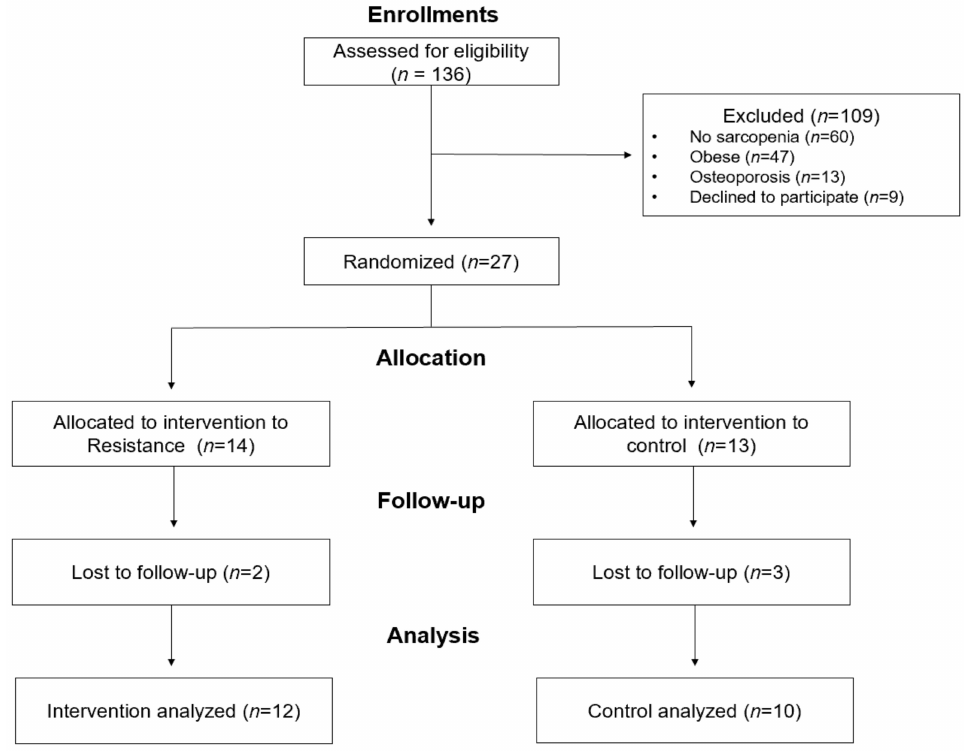
Figure 1. Flow chart of the